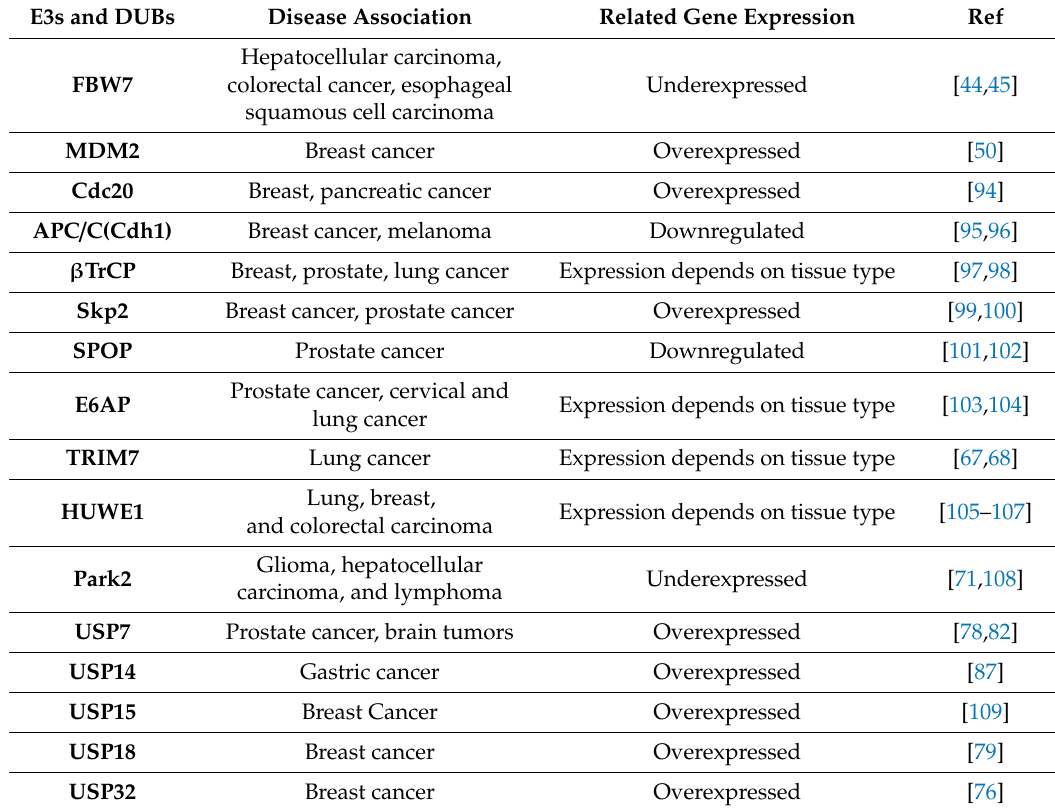
Table 2. Summary of related gene expressions of discussed E3 ubiquitin–protein ligases and deubiquitinases or deubiquitinating enzymes (DUBs) in specific types of